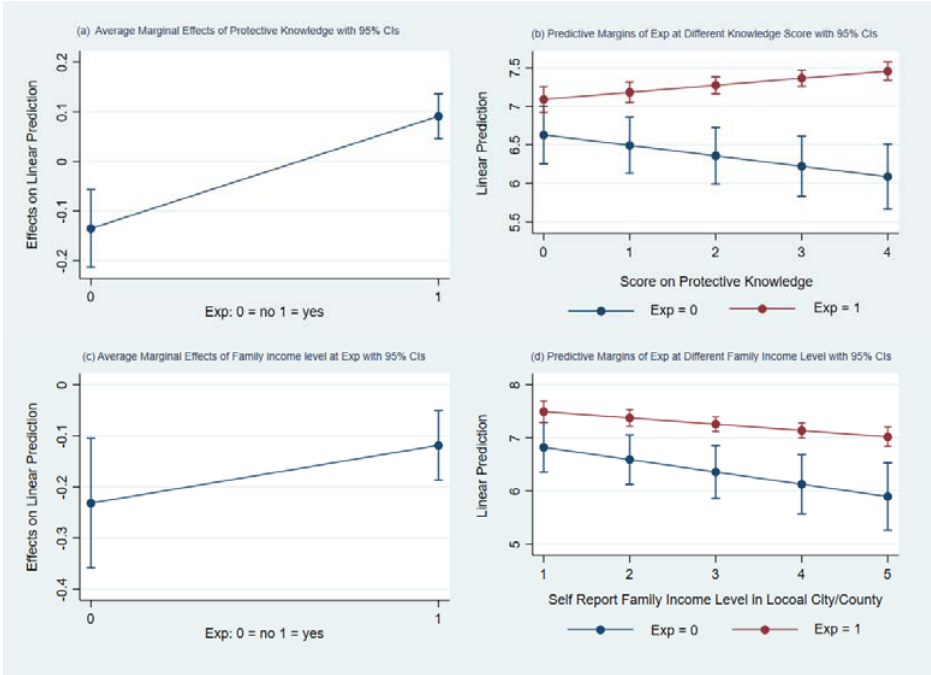
Figure 4. Interaction effect of smog avoidance, information application ability and self-rated social stratification.